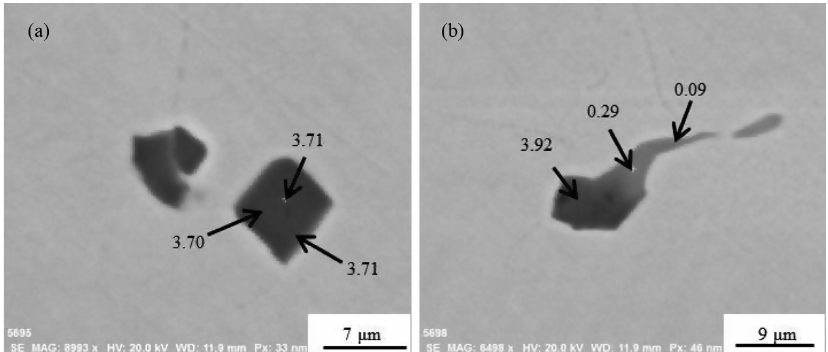
Figure 2: Large precipitates containing Ti, (a) Ti-rich phase, (b) Ti-V-rich phase, the numbers represent the Ti/V atomic ratio at the position the arrow pointing